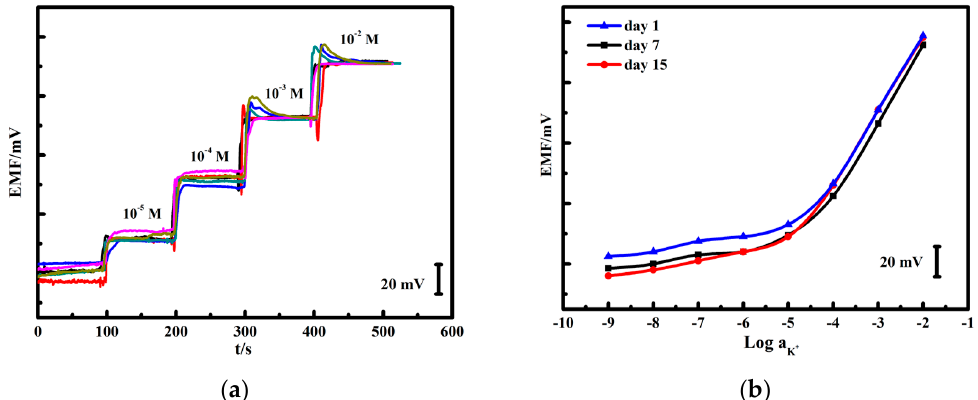
Figure 5. ( a ) Time-dependent potential response trace of the GC/MoS 2 /Fe 3 O 4 /K + -ISE for 6 times. ( b ) Calibration curve of the GC/MoS 2 /Fe 3 O 4 /K + -ISE on different